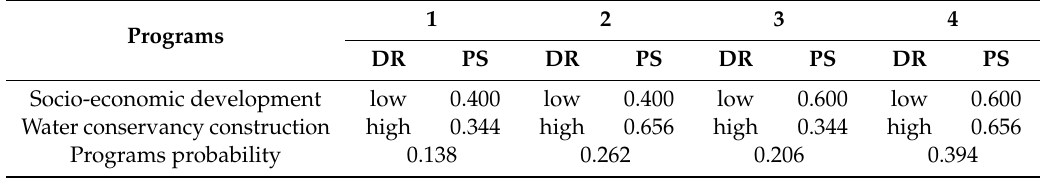
Table 6. Expert advice probability results table of di ff erent supply and demand programs in 2020.